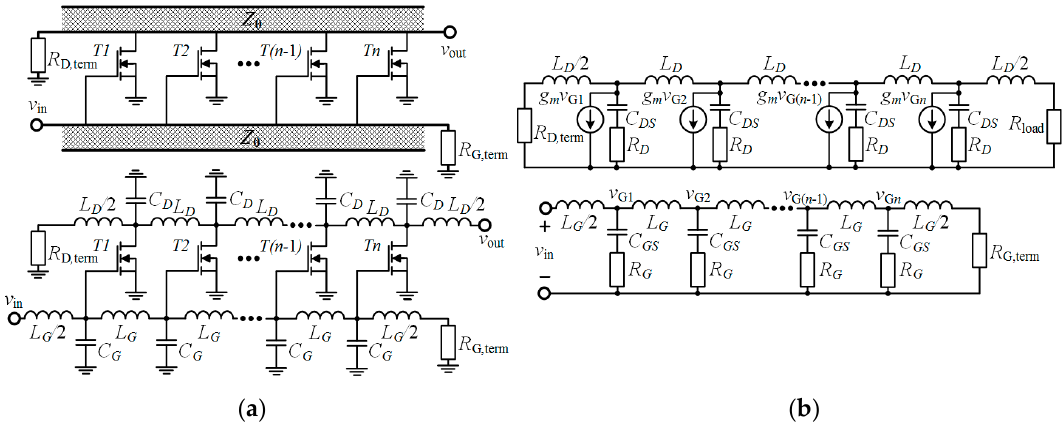
Figure 1. Traveling-wave amplifier (TWA): ( a ) concept and ( b ) small-signal model.